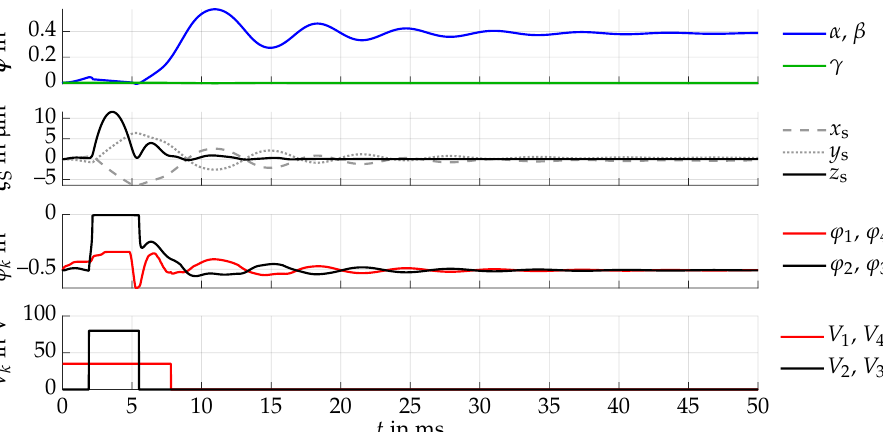
Figure 5. The optimized rectangular voltages (bottom) are applied to the actuators, resulting in a delayed pull-in motion for beams 2–3 (second last). Due to this force, the sphere is kicked upwards, drifting into the hind left (second). The sphere rotation (top) is then induced by a complex combination of the impact with beams 1–2 as well as releasing beams 3–4 from the pull-in. After a settling time of approximately 50ms, the sphere achieves a diagonal rotation of α = β =